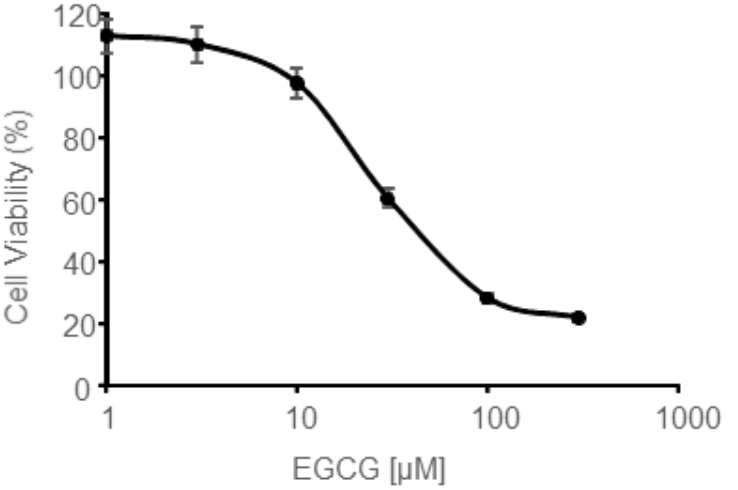
Figure 5. Cell viability was assessed using the crystal violet assay after 24 h of incubation with increasing concentrations of EGCG ranging from 1 to 300 µ increasing concentrations of EGCG ranging from 1 to 300 µM.